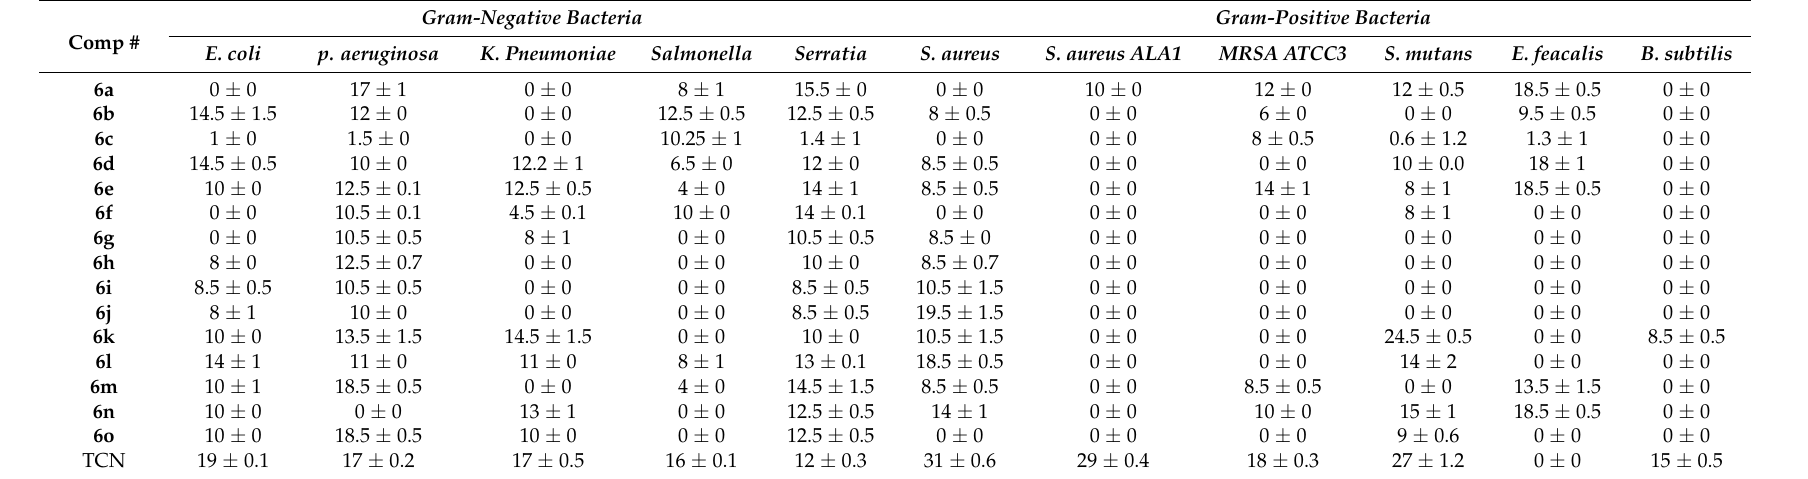
Table 1. Antibacterial activities of the synthesized hydrazones 6a – o